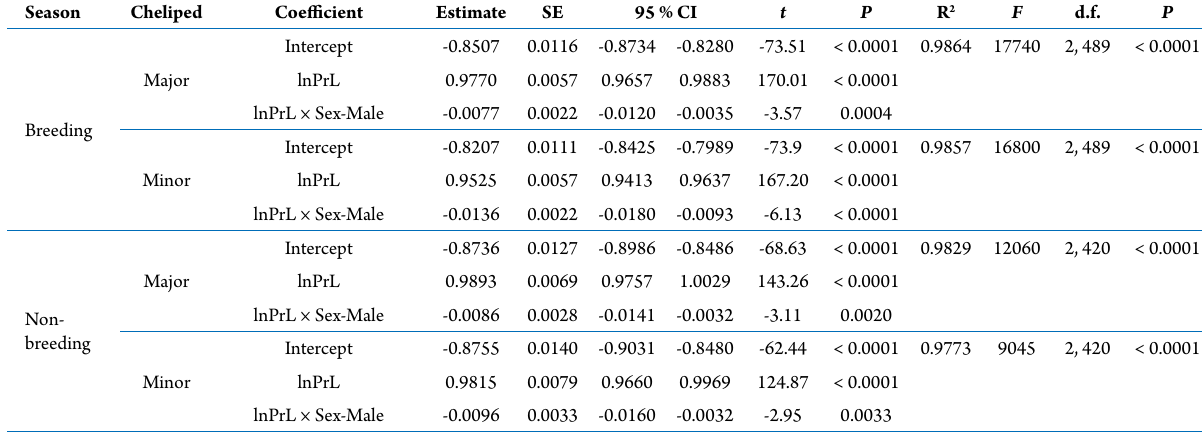
Table A3. Coefficient estimates with standard errors (SE) and their 95 % confidence intervals (CI) for their explanatory variables of log-transformed allometric growth equation models to evaluate the intersexual chela shape dimorphism of major or minor chelipeds in the breeding (May to September) and non-breeding seasons (October to April) of the porcellanid crab Petrolisthes japonicus . The linear equation model was as follows: lnPrW ~ ln a + b lnPrL + c lnPrL × Sex, where PrW is the cheliped propodus width, PrL is the cheliped propodus length, and Sex is female or male. The coefficient estimate for each explanatory variable, including the Sex, was the output for the male, representing changes in the response variable relative to the baseline category (female). The statistical significance of the coefficient estimates and each model was evaluated with t -tests and F -tests,